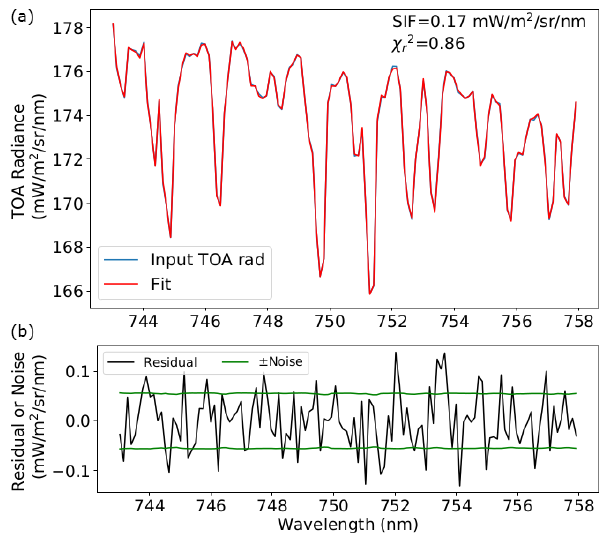
Figure 5. Example of spectral fit for the 743–758nm fitting win- dow. The fit residual is compared to the noise level included in the input L1B dataset for the same spectrum. The resulting SIF values at 740nm and χ 2 r of the fit are shown in panel (b)